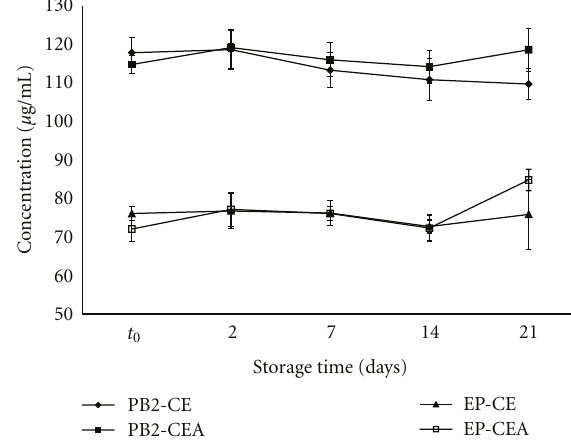
Figure 3: The stability of the crude extract (CE) and the crude extract + colloidal silicon dioxide (CEA) of Guazuma ulmifolia at 45 ◦ C, 75% relative humidity and 21